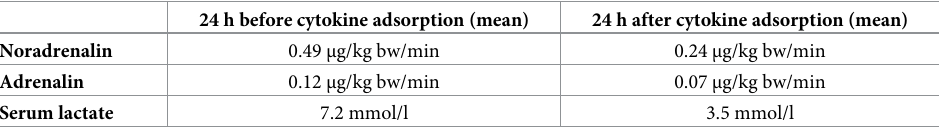
Table 4. Hemodynamic